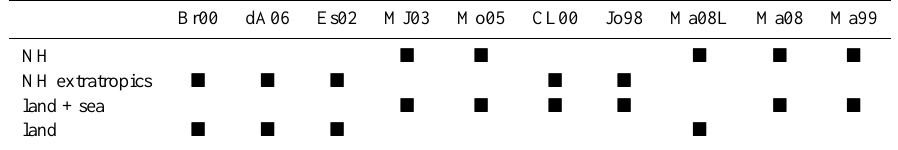
Fig. 3. The five clusters of reconstructions (smoothed). Note that Ma99 forms a single cluster. Table 3. Target area for